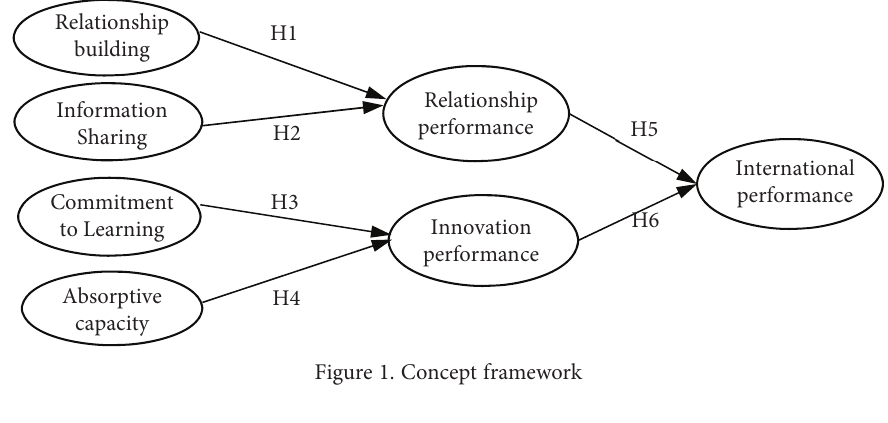
Figure 1. Concept